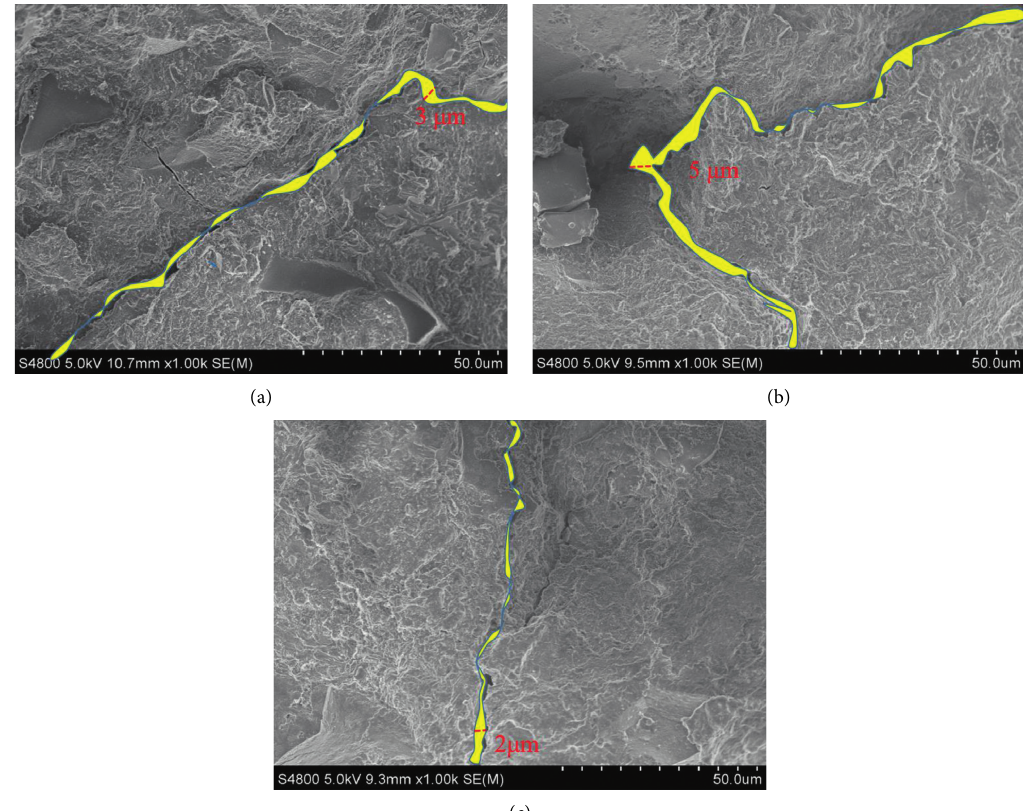
Figure 7: Concrete crack width. (a) CI0P0. (b) CI30P0. (c) CI30P0.1.